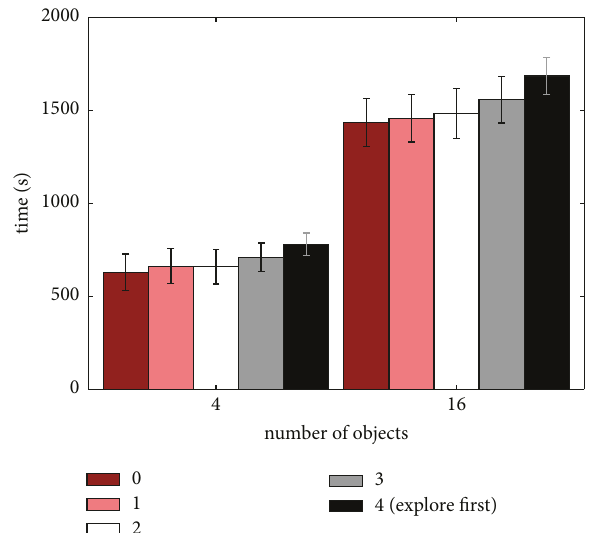
Figure 18: Results based on our method. The legend shows the benchmark agent id: minimal numbers of exploring agents.